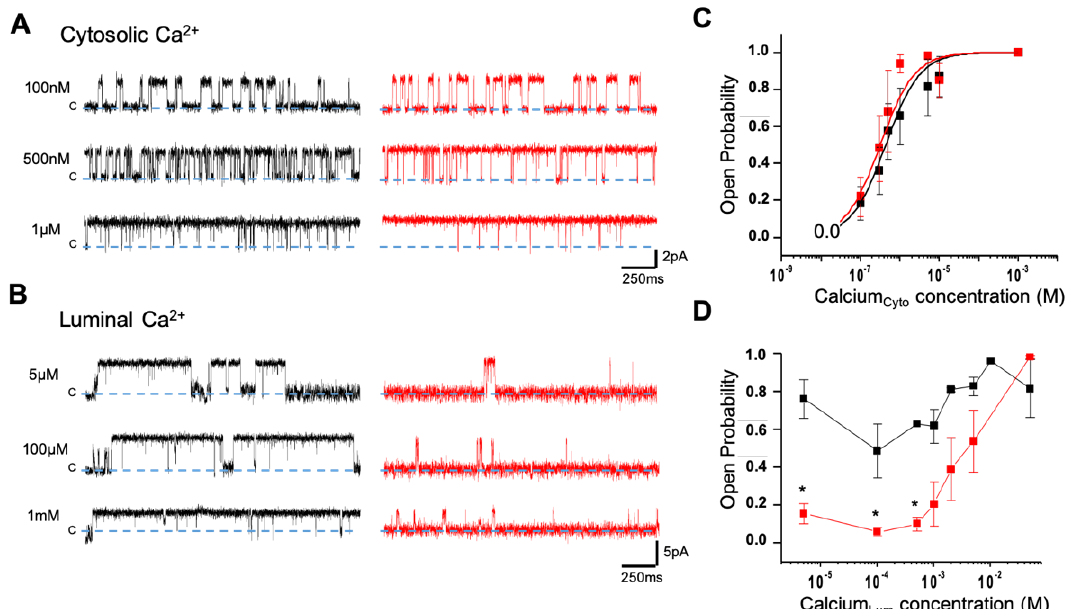
Figure 7. Cytosolic and luminal Ca 2+ regulation of the D3291V-RyR2 channels: ( A ) Single-channel recordings from WT-RyR2 (black) and D3291V-RyR2 (red) were recorded at a membrane holding potential of 0 mV at three different cytosolic free Ca 2+ concentrations. Open events are upward deflections from zero current level (blue dotted line, c). The cytosolic solution contained 120 mM Tris and 250 mM HEPES (pH 7.4), and the cytosolic Ca 2+ levels were adjusted with 0.2 mM BAPTA and 1 mM Dibromo-BAPTA in Cis . Trans solution contained 50 mM Ca 2+ and 250 mM HEPES (pH 7.4). ( B ) Single-channel traces from WT-RyR2 (black) and D3291V-RyR2 (red) were recorded in symmetrical conditions of 250 mM CsCH 3 O 3 S, 20 mM HEPES, pH 7.4. In Trans , the desired luminal Ca 2+ levels were adjusted with 1 mM BAPTA with the cytosolic free Ca 2+ concentration set to 5 µ M in Cis . Channel activity was taken at +20 mV holding potential. ( C ) Open probabilities of WT-RyR2 (black squares) and D3291V-RyR2 (red squares) obtained, under the same conditions as in A, and challenged with increasing free [Ca 2+ ] in Cis . The sigmoidal curves resulted from the fitting using a Hill function: y = Vmax × x n /(k n + x n ) where Vmax is the max velocity, k is Michaelis constant, and n is the number of cooperative sites. At the same concentrations of free Ca 2+ , the open probability of WT-RyR2 and D3291V-RyR2 channels were not significantly different. (ANOVA, one-way analysis at p < 0.05). The EC 50 ’s for the WT-RyR2 and D3291V-RyR2 were 438 ± 75nM (n = 2-7) and 320 ± 41nM (n = 3-5), respectively. ( D ) Open probabilities of WT-RyR2 (black squares) and D3291V-RyR2 (red squares) obtained under the same conditions as in C, and challenged with increasing free [Ca 2+ ] in Trans. The open probabilities of WT and D3291V-RyR2 channels were significantly different at low luminal concentrations of free Ca 2+ (ANOVA one-way test at p < 0.05). Currents traces were filtered at 800 Hz.